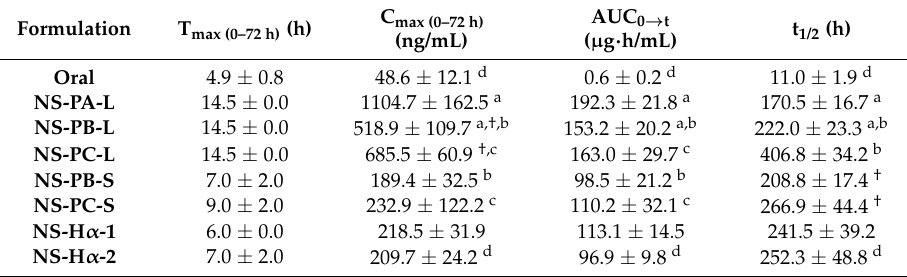
Table 3. Pharmacokinetic parameters of oral administration (Mean ± SD, n = 4).